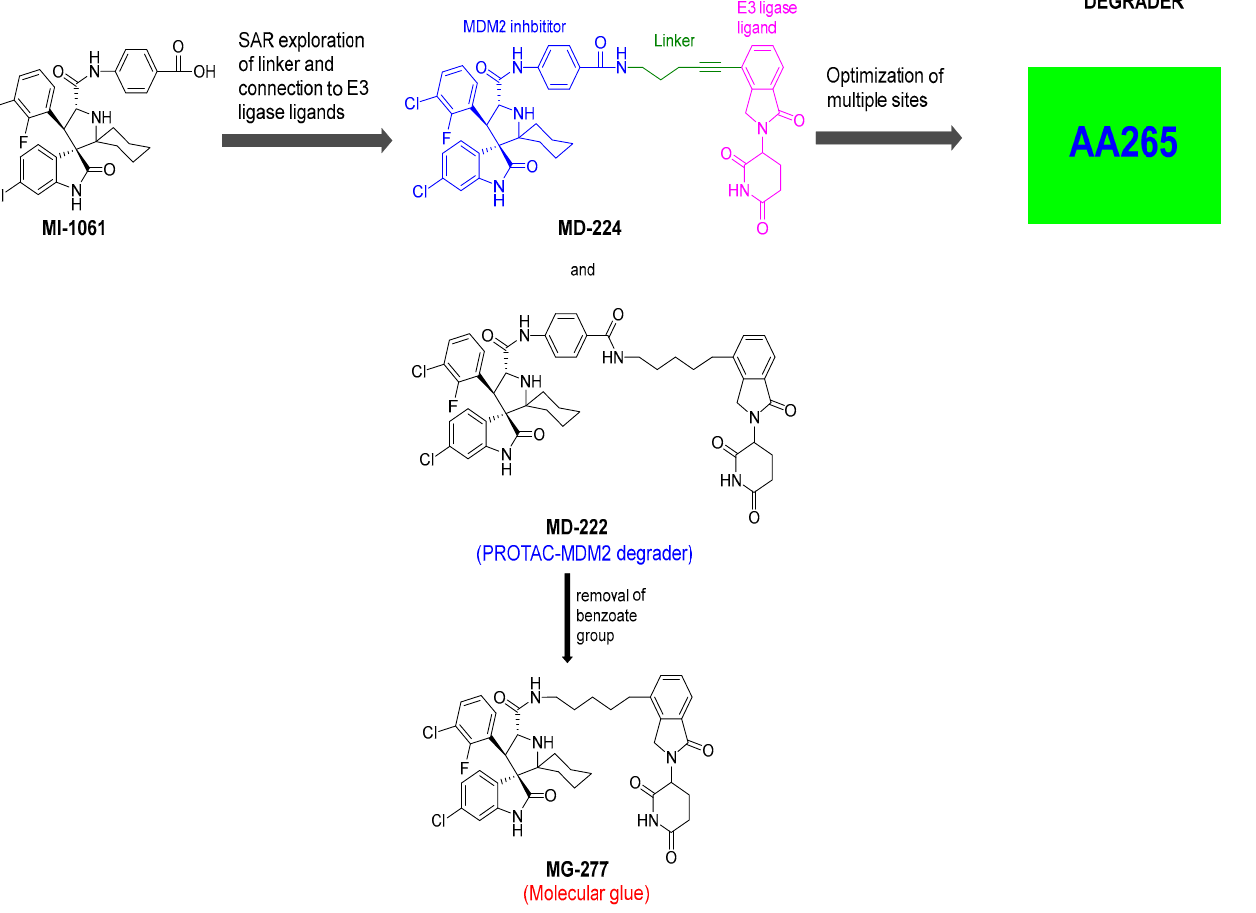
Figure 8. Discovery of PROTAC–MDM2 degrader and molecular glue that degrades GSPT1.